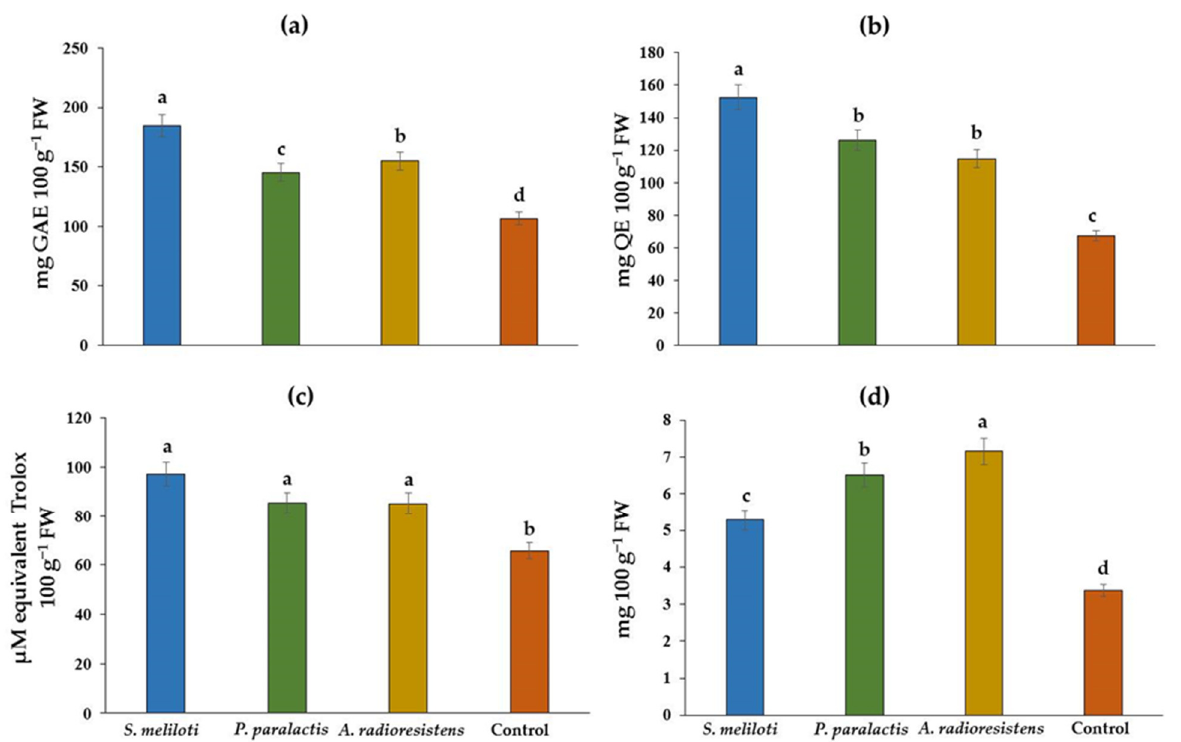
Figure 1. Effect of PGPR on the content of phenolic compounds ( a ), flavonoids ( b ), antioxidant capacity ( c ), and vitamin C ( d ) in C. sativus fruit under greenhouse conditions. Different letters indicate a significant difference ( p < 0.05) according to Tukey’s test.